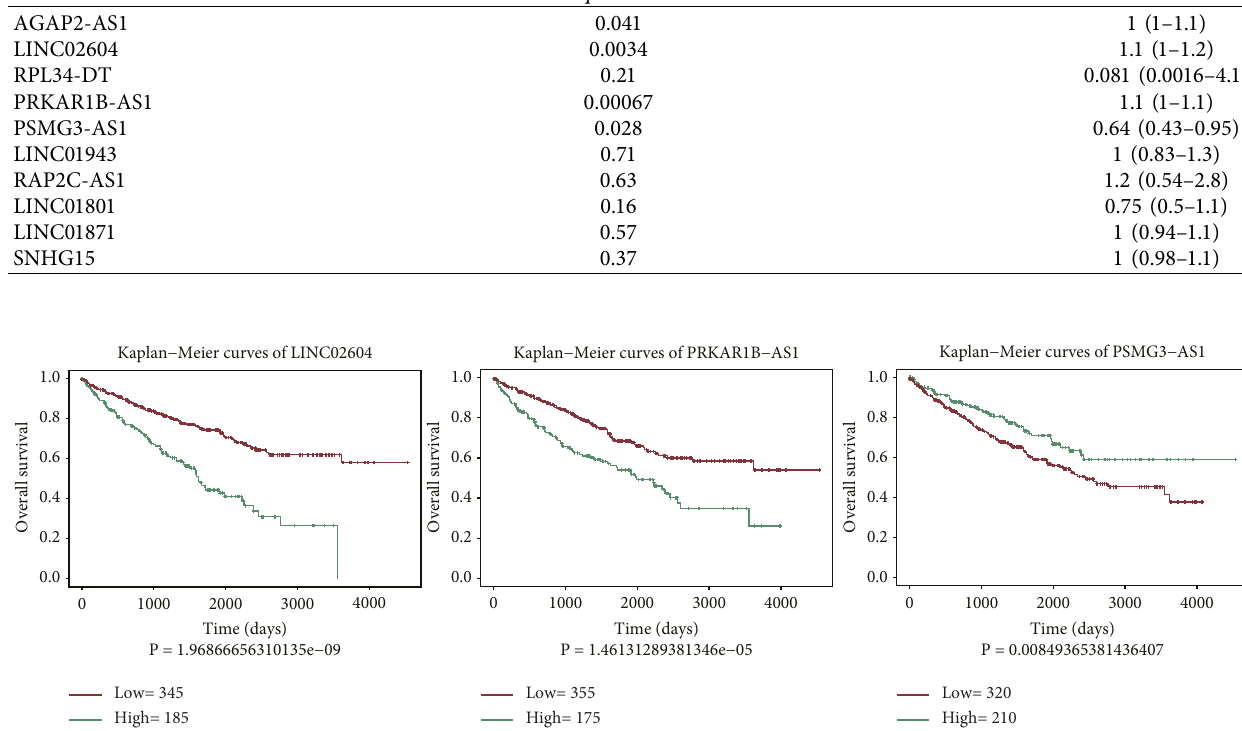
Figure 3: Identifcation of the KIRC prognosis signature. (a) Kaplan–Meier survival analysis chart of signifcant lncRNAs.